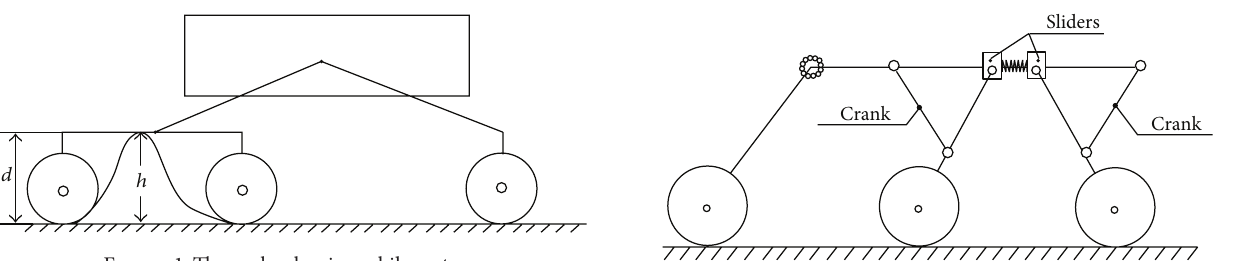
Figure 3: Six-wheeled and double crank slider suspension system.